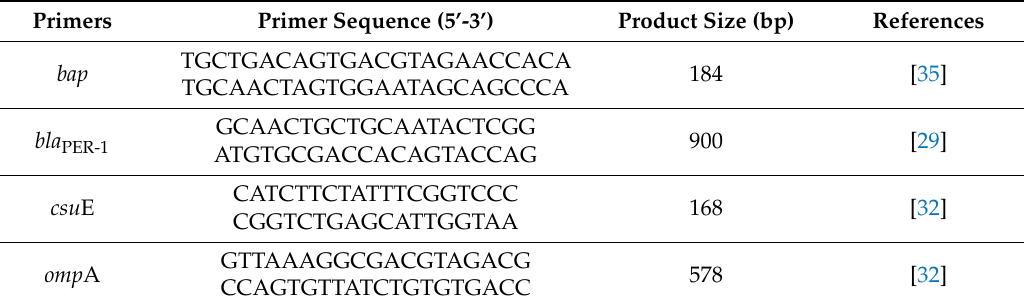
Table 3. The primers used in this study for detection of biofilm related